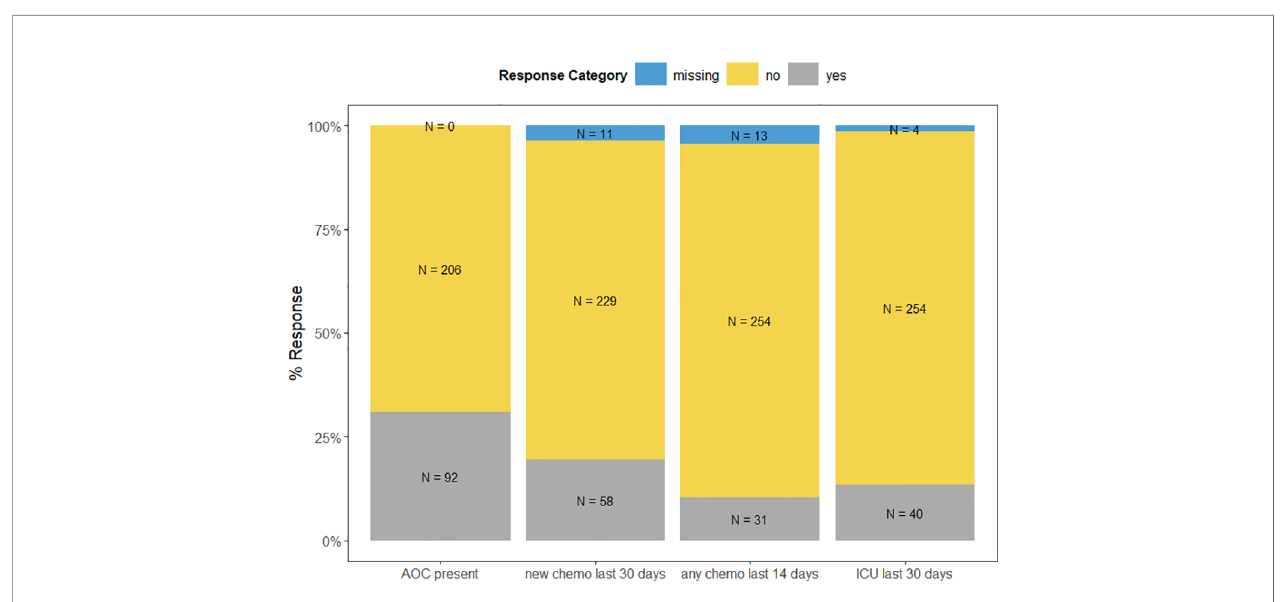
FIGURE 2 | Frequencies of AOC